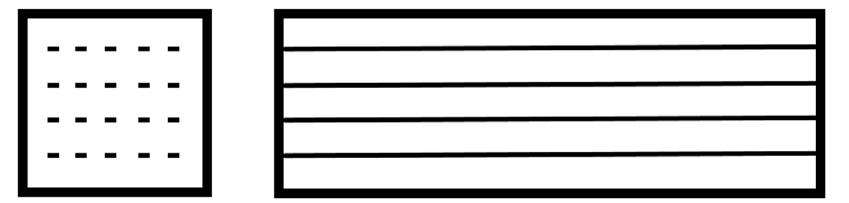
Figure 3. Fiber distribution in the cross-section of the sample and distribution along the sample.